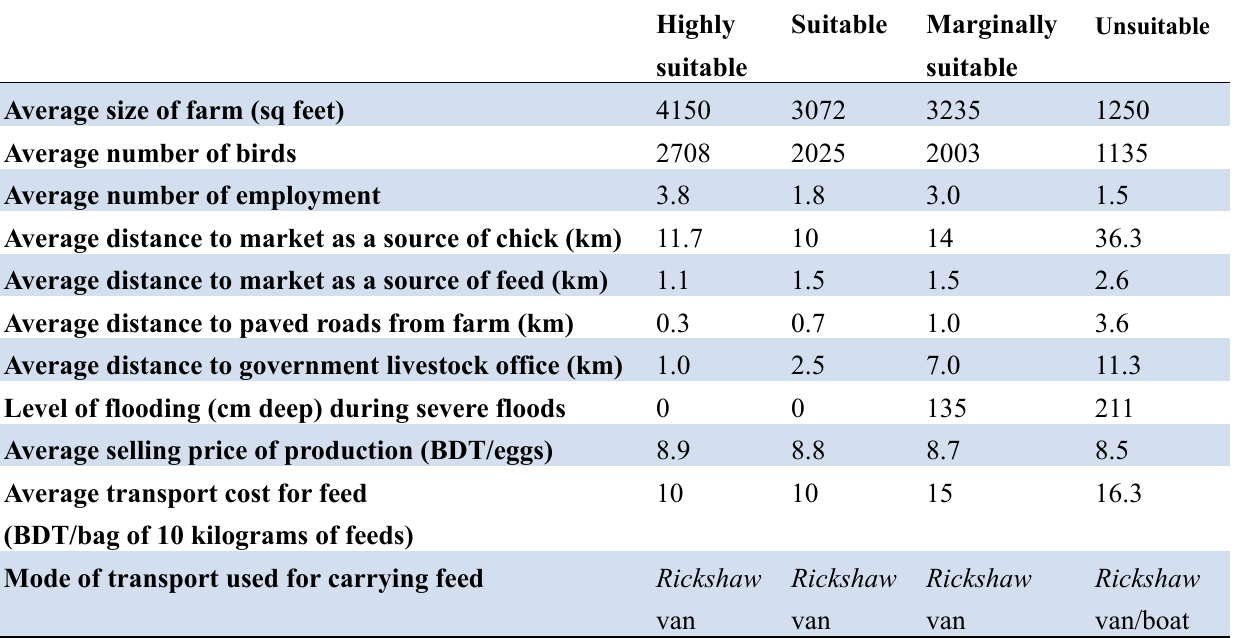
Table 4. Environment and characteristics and price of poultry production in different suitability sites.